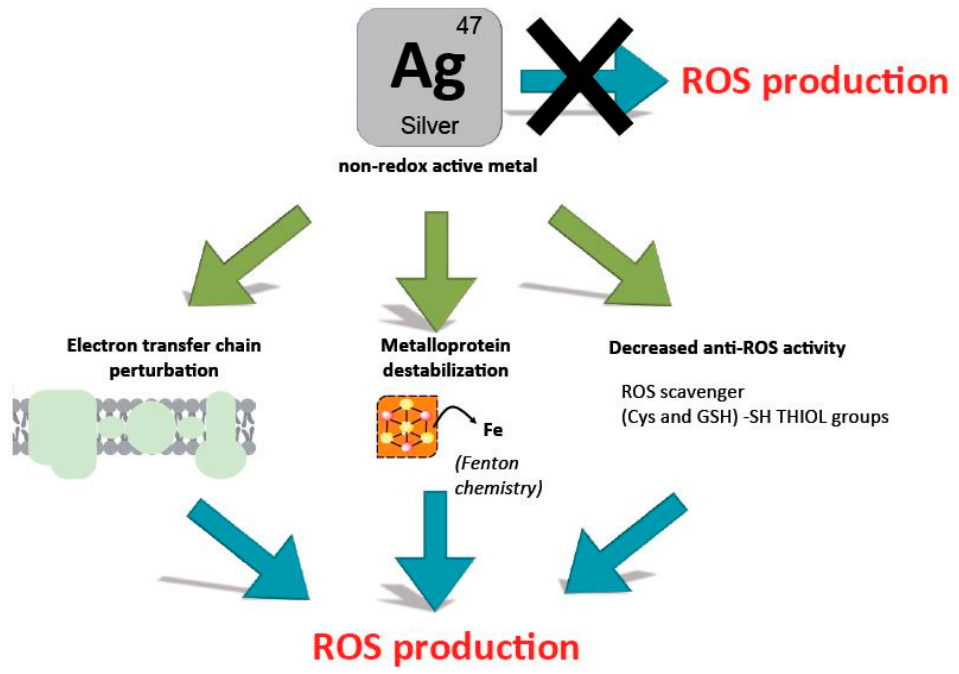
Figure 2. Searching for the causal link between silver ions and ROS production. Silver is a